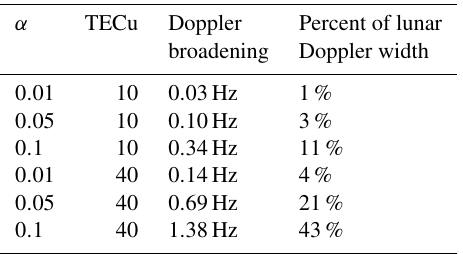
Table 2. Effect of TIDs on Doppler broadening under various con- ditions.